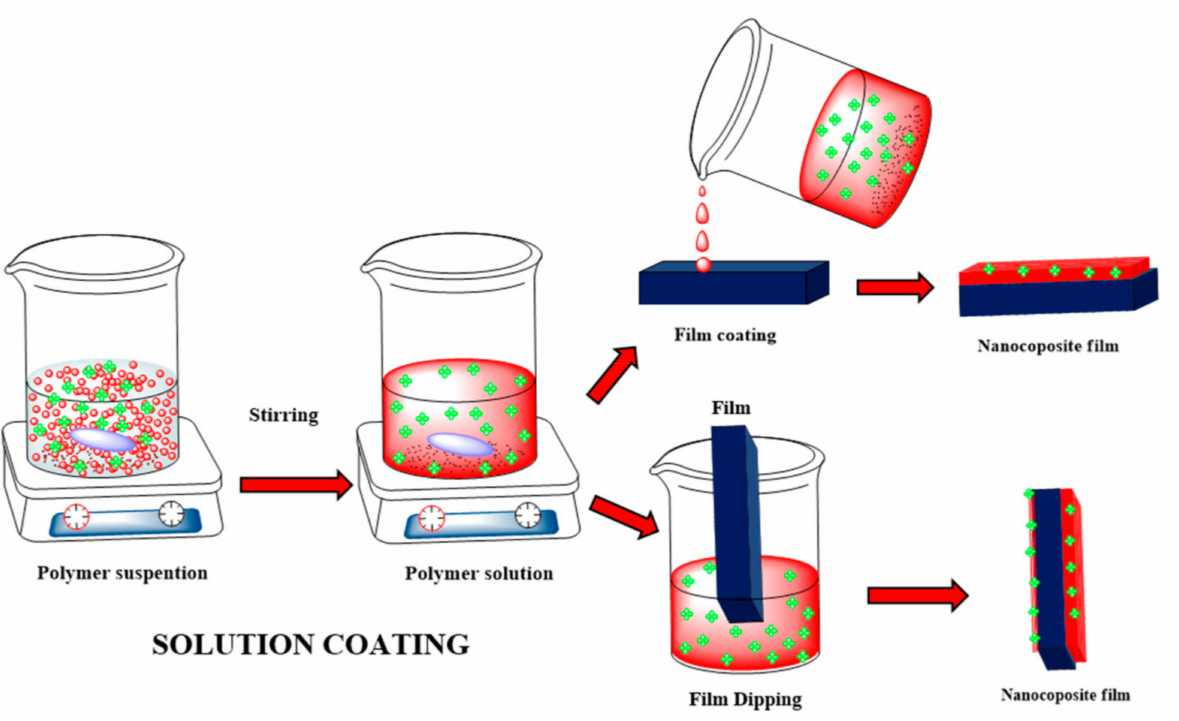
Figure 16. Schematic representation of the fabrication of a polymeric membrane [Reprinted with permission from ref. [196], Roy, S.; Singha, N.R. Polymeric Nanocomposite Membranes for Next Generation Pervaporation Process: Strategies, Challenges and Future Prospects. Membranes 2017 , 7 , 53. https://doi.org/10.3390/membranes7030053], Copyright ©